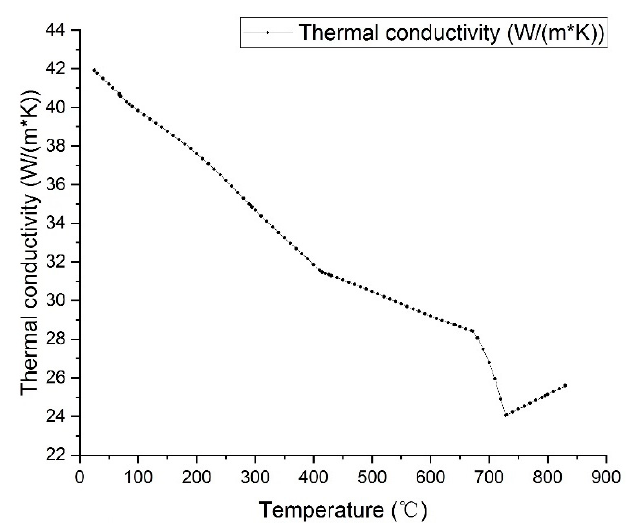
Figure 3. Thermal conductivity of the surface.